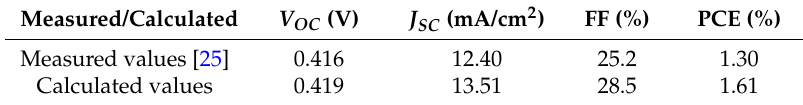
Table 2. Calculated vs. measured performance parameters of the solar cell reported in [25].